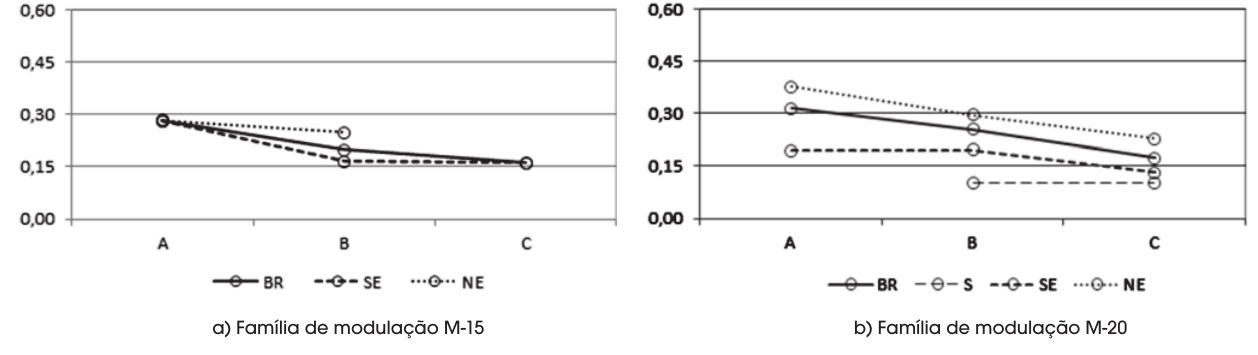
) em relação às famílias de modulação bm